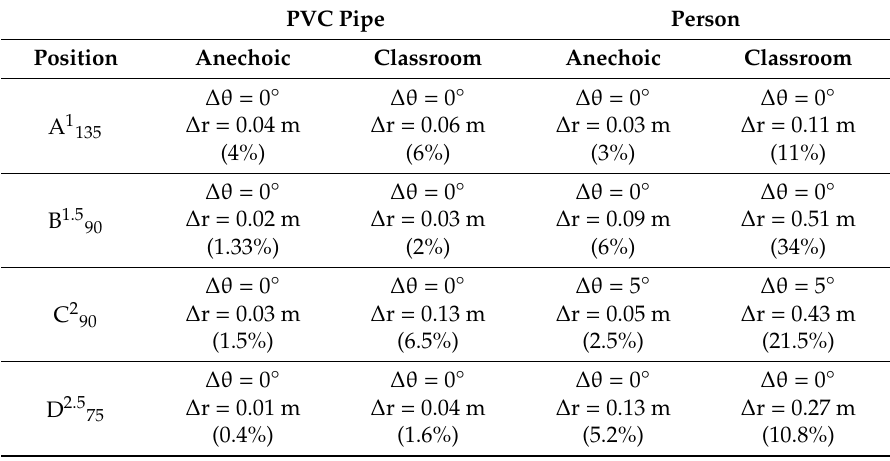
Figure 14. Energy maps of Case 1 and Case 2 to verify the localization performance in a classroom: The Case 1 of a PVC pipe in ( a ) position A; ( b ) position B; ( c ) position C; ( d ) position D; Case 2 of a person in ( e ) position A; ( f ) position B; ( g ) position C; ( h ) position D. The square marker is the actual position and the cross marker is the estimated position. Table 4. Position errors of a PVC pipe and a person in terms of localization